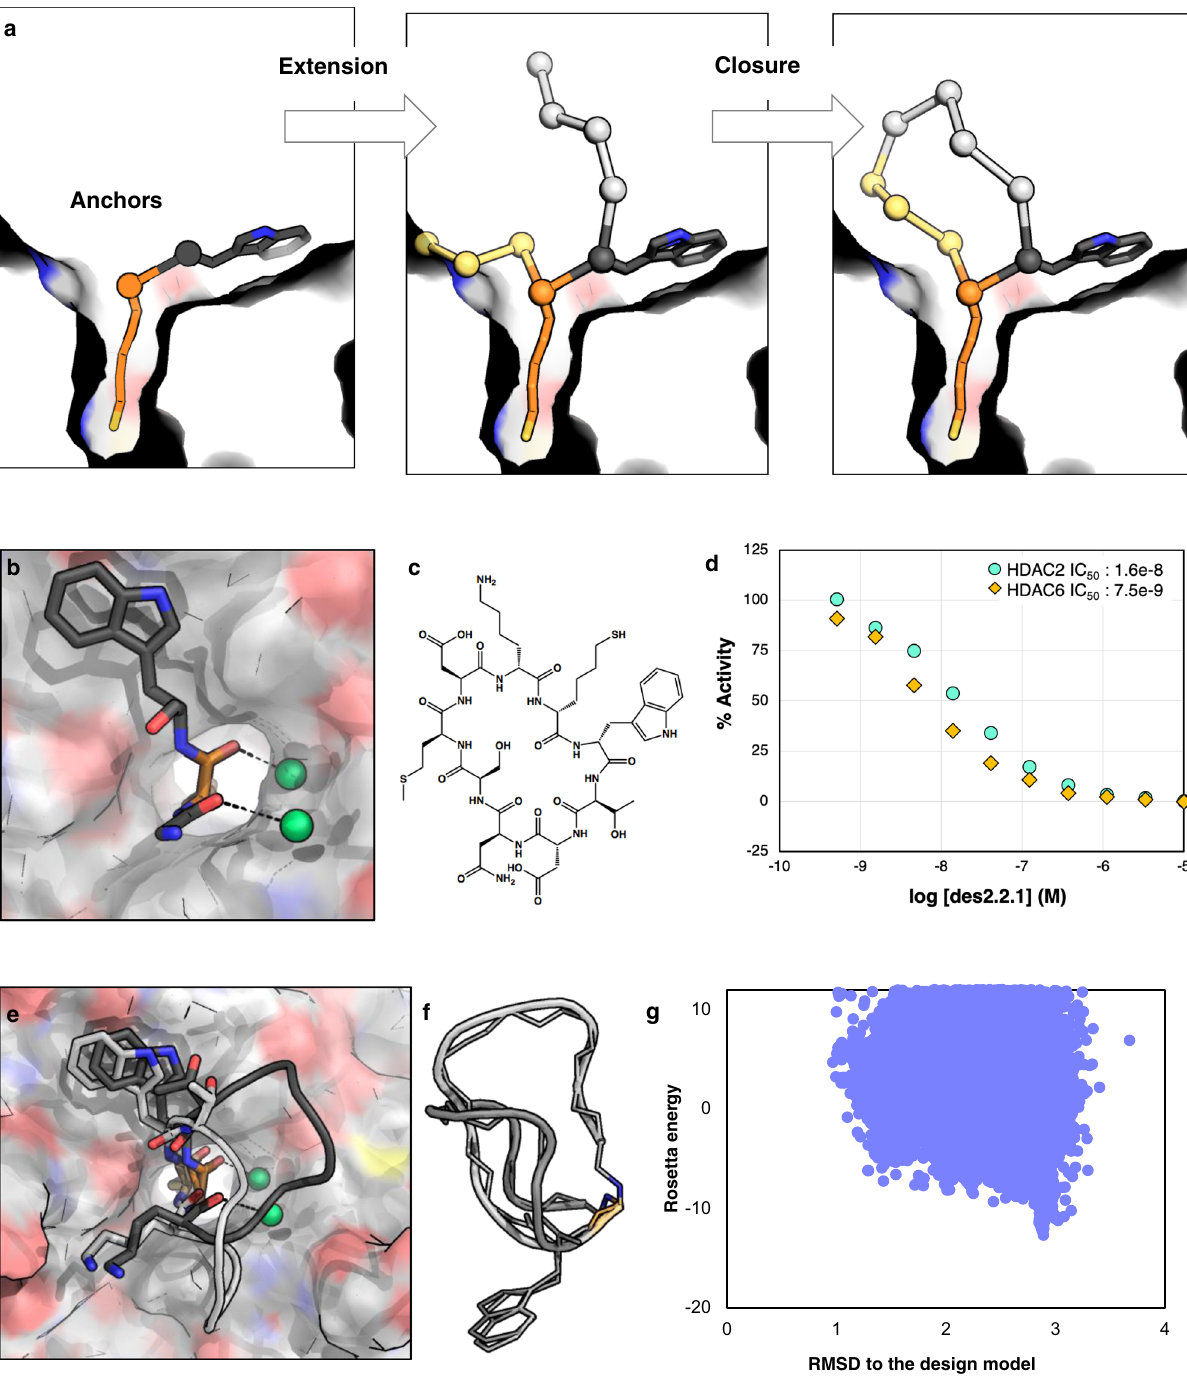
Fig. 3 Design method 2 results in peptides that bind in predicted mode by taking advantage of an additional anchor and including waters. a Schematic of design method 2: anchors are extended, and the new peptide chain is closed inside the protein pocket. b In this round of designs, a Trp residue was added as an anchor in addition to SHA, and the backbone orientation of SHA and the preceding residue were fi xed to orient two structural waters at the interface. c Chemical structure of des2.1.1. d des2.1.1 has an IC 50 value of 16.3 nM against HDAC2 and slight preference for HDAC6 over HDAC2 (Source Data are provided as a Source Data fi le). e Crystal structure of des2.1.1 (PDB ID: 6WI3, light gray) shows a conformation consistent with the designed model for SHA, Trp, and waters at the interface; however, the rest of the peptide shows higher fl exibility. The original model is shown in dark gray. f The binding-competent backbone conformation from the crystal structure (light gray) is different from the NMR structure of the peptide in solution (dark gray), suggesting a conformational change upon binding. Both of these structures differ from the design model. The sidechains, except for Trp are removed for clarity. g The fl exibility of des2.1.1 is consistent with conformational sampling results, suggesting that this peptide can sample a number of different conformational states far from the designed model (Source Data are provided as a Source Data fi